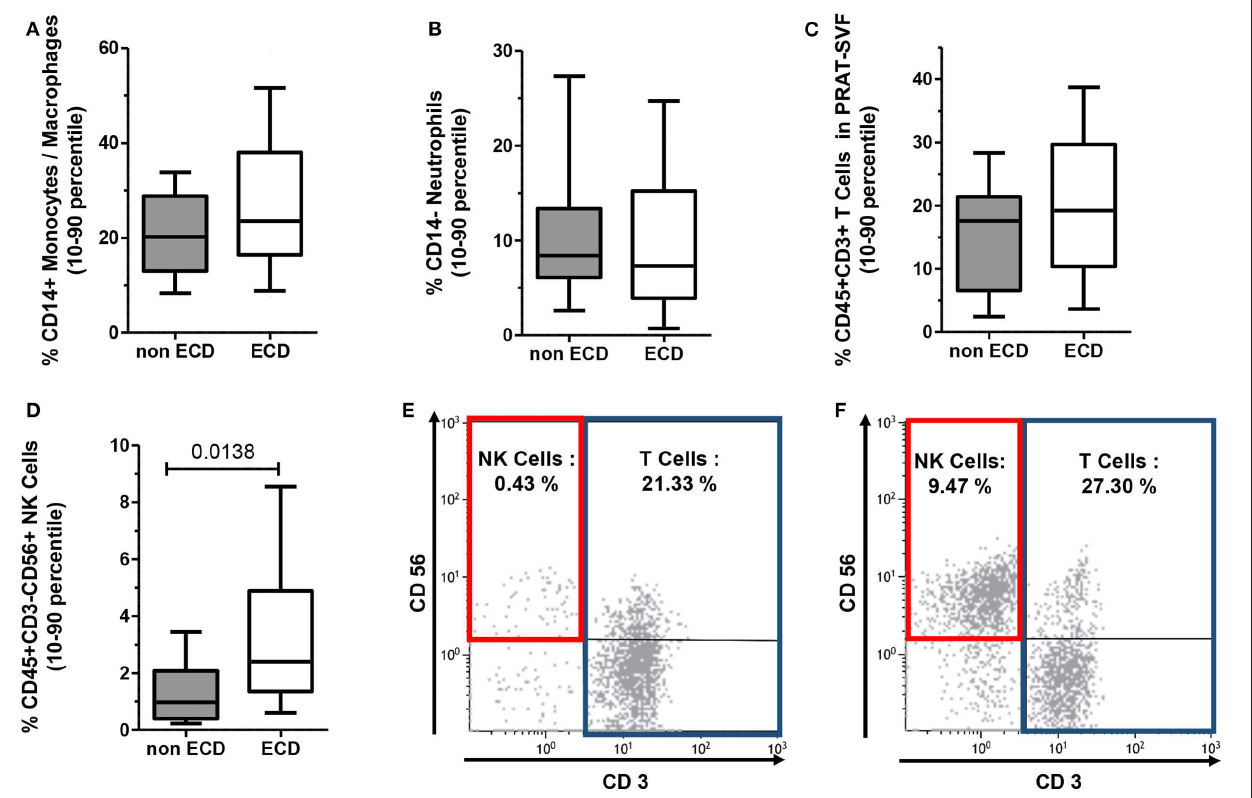
FIGURE 4 | The distribution of CD45 + hematopoietic cells composing the PRAT-SVF of ECD and non-ECD donors was analyzed using flow cytometry according to the gating strategy illustrated in Supplementary Figure 1 . Results on the graphs are reported as box and whiskers plots representative of median values, and 25–75 interquartile ranges (Boxes) and error bars indicative of 10–90 percentile ranges. (A) CD14 + Monocyte/Macrophage subset. (B) CD14-neutrophil subset. (C) CD3 + T lymphocytes. (D) CD3 − CD56 + NK cells. (E) Histograms illustrate the gating and % of CD3 + T cells and CD3-CD56 + NK Cells observed when analyzing PRAT-SVF of a non-ECD donor (0.43% of NK Cells) or (F) PRAT-SVF from an ECD donor (9.47% of NK